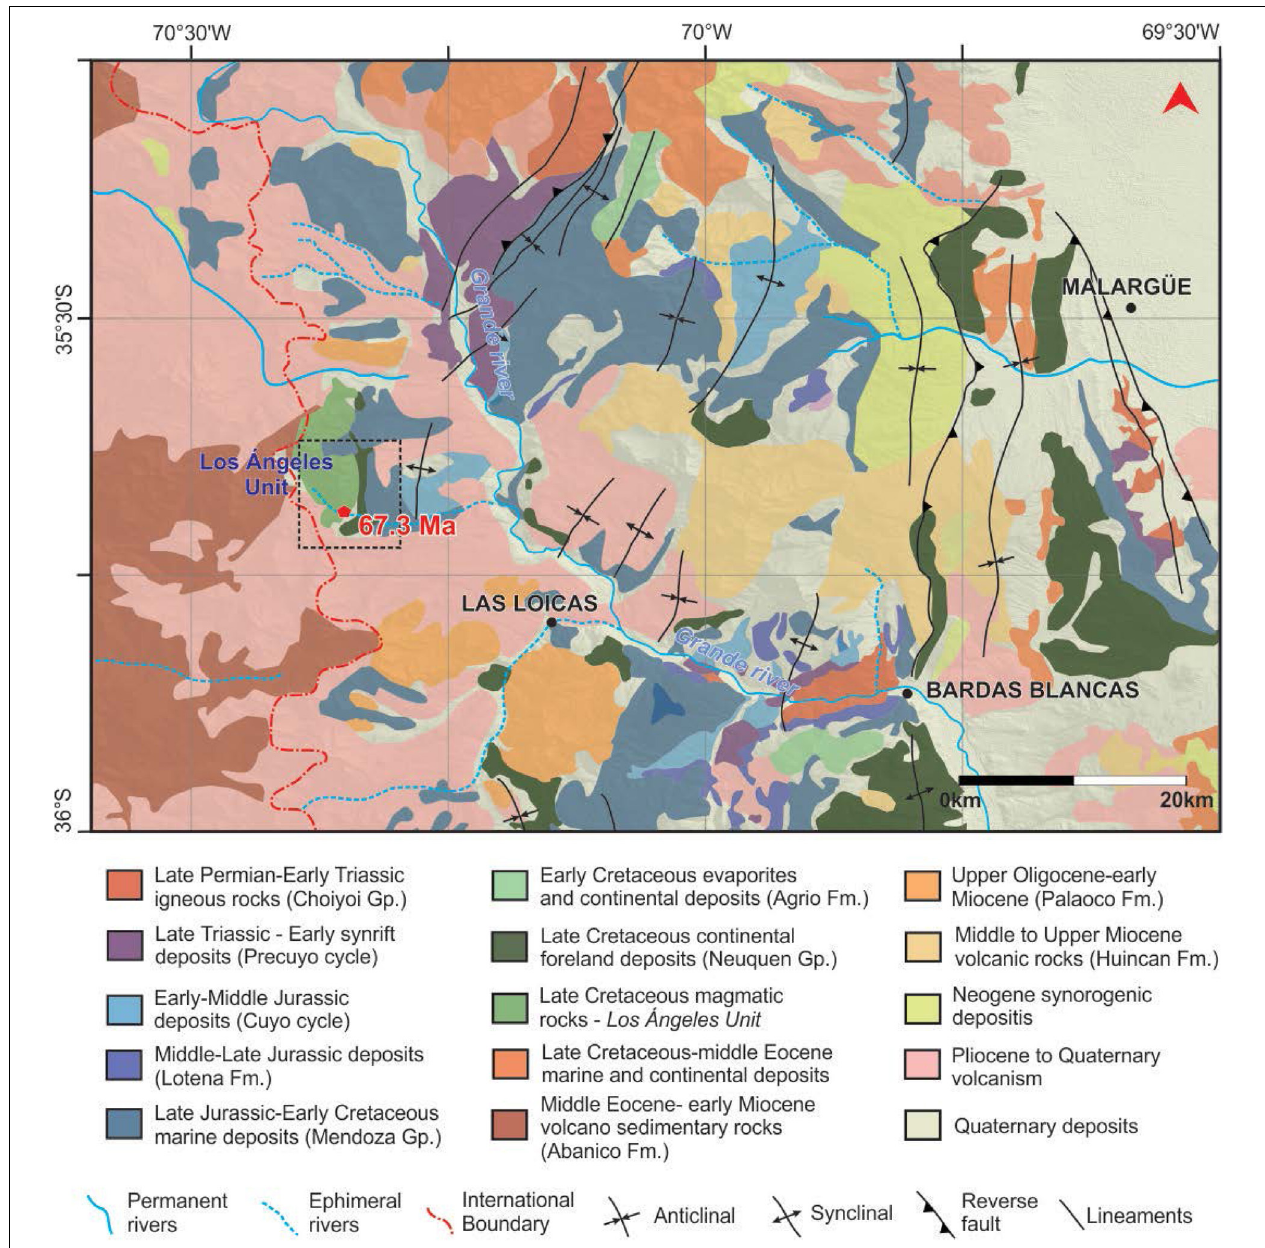
FIGURE 2 | Detailed map showing the main geological units recognized in the Southern Central Andes between 35 and 36 ◦ S. The black box shows the studied area where the Los Ángeles Unit crops out. Based on Fennell et al. (2019) and Nullo et al.